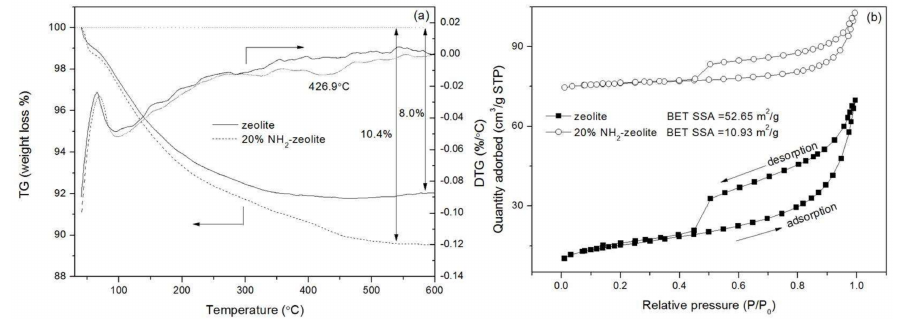
Figure 4. Thermal gravimetric and differential thermal gravimetric analysis (TG-DTG) curves ( a ) and